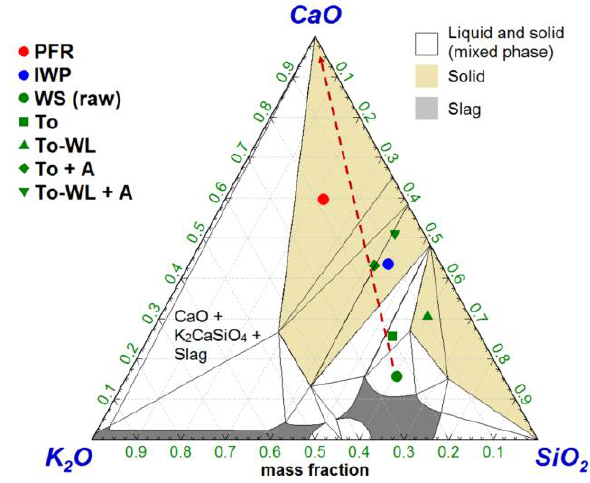
Figure 13. Calculated ternary phase diagram for the SiO 2 -CaO-K 2 O system using FactSage [32]. The phases were predicted for (pre-treated) wheat straw, as well as IWP (benchmark material) and PFR (chosen as alternative woody waste biomass). The calculation was performed under isothermal conditions at 950 °C.